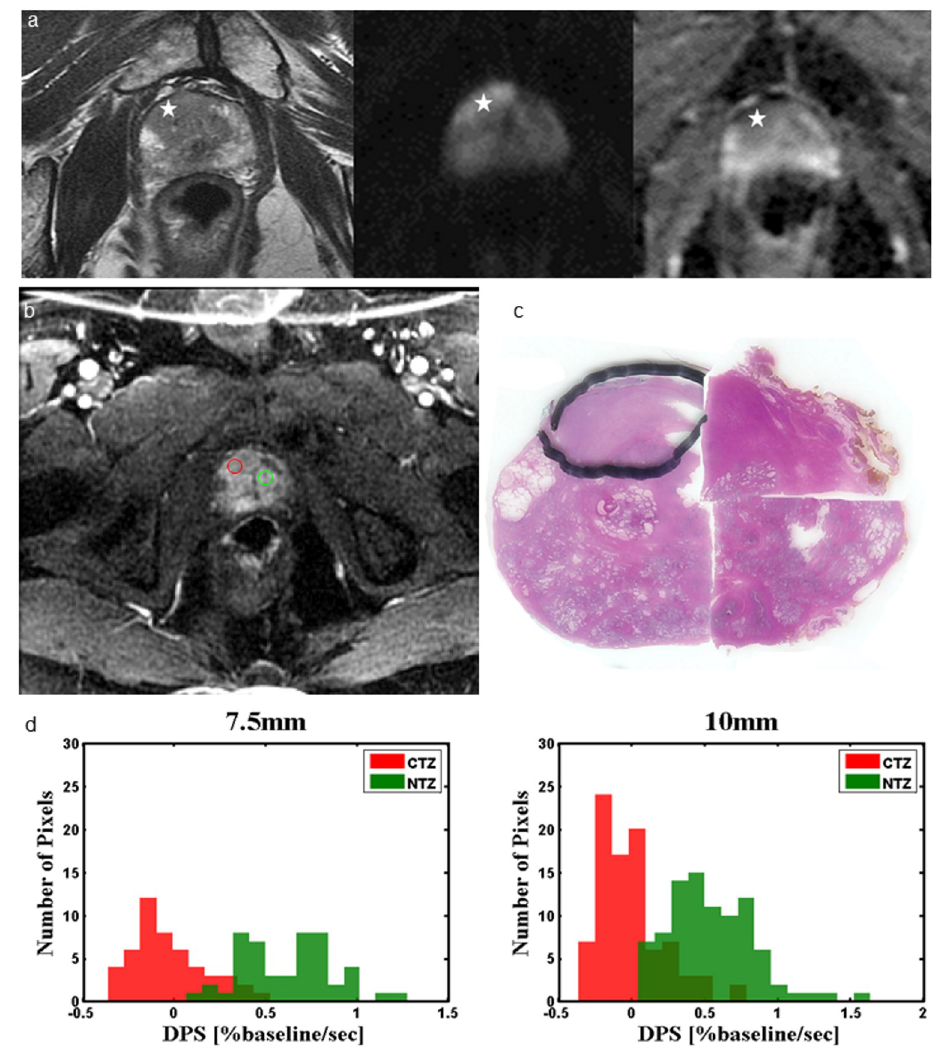
Fig 1. Example of the selected ROI. A 57-year-old patient with elevated PSA levels and previous negative systematic TRUS biopsy. (a) 3T mp-MRI (from left to right: T 2 -weighted fast spin-echo imaging, DWI, and ADC map) demonstrates an area suspected to be cancerous (stars), which was confirmed by performing targeted TRUS biopsy. (b) ROI selection was performed on the basis of corresponding DCE-MRI for CTZ (red circle) and NTZ (green circle). (c) The pathological slice at the corresponding level was correlated to confirm the representativeness of the selected ROI (circled by a marker). (d) The histogram at different diameters of the ROI of CTZ and NTZ. A total of 60 ROIs with a diameter of 7.5 mm were selected in pairs in 30 patients, including 16, 16, 14, and 14 in the CTZ, NTZ, CPZ, and NPZ, respectively. The median tumor width was